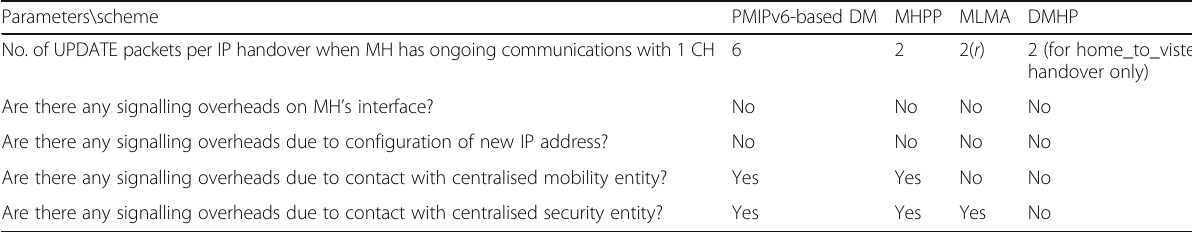
Table 2 Signaling overheads of PMIPv6-based distributed mobility, MHP, MLMA, and DMHP Parameters\scheme